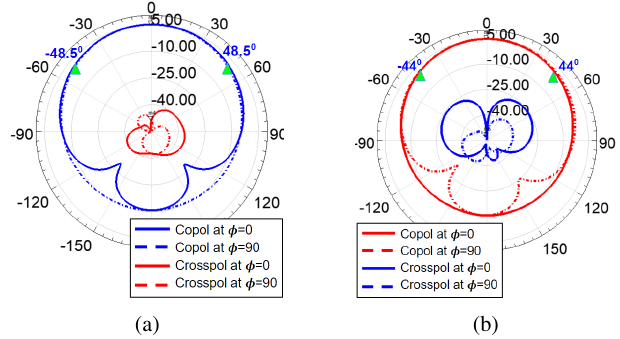
FIGURE 3: Gain pattern with (a) H port excited and (b) V port excited are -53.85 dB and -55.92 dB for H and V polarizations, re- spectively. The -3 dB beamwidth is approximately 97 . 8 o and